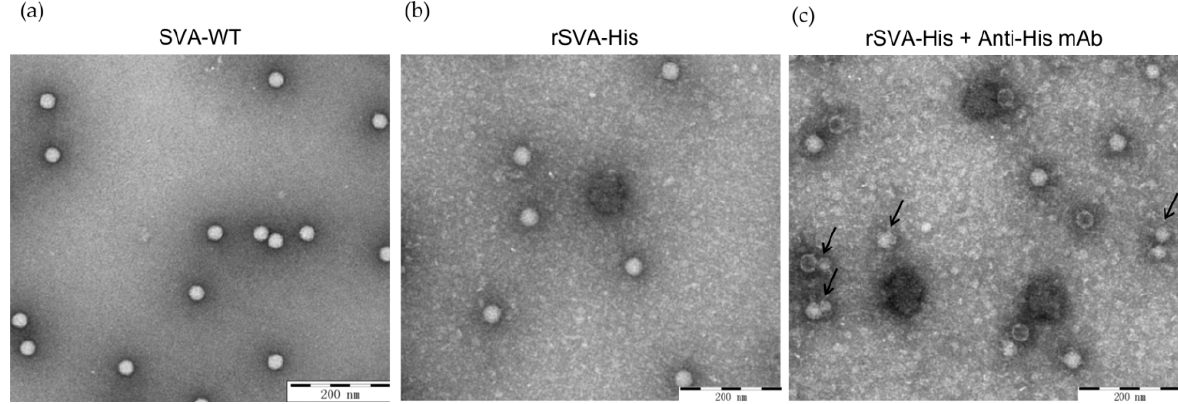
Figure 5. Observation of rSVA ‐ His on transmission electron microscopy. ( a , b ) Morphology of rSVA ‐ His and parental virus. ( c ) EM image of rSVA ‐ His incubated with anti ‐ His mAb. Black ar ‐ rows indicate specific binding of anti ‐ His mAb to rSVA ‐